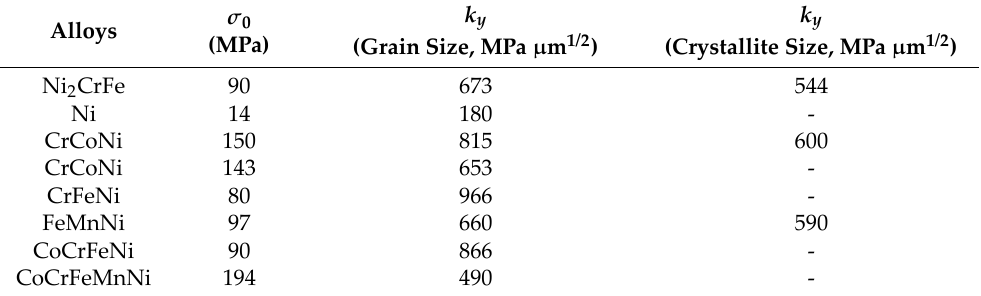
Table 3. Hall‑Petch parameters of Ni 2 CrFe MEA and comparison with FCC type alloys